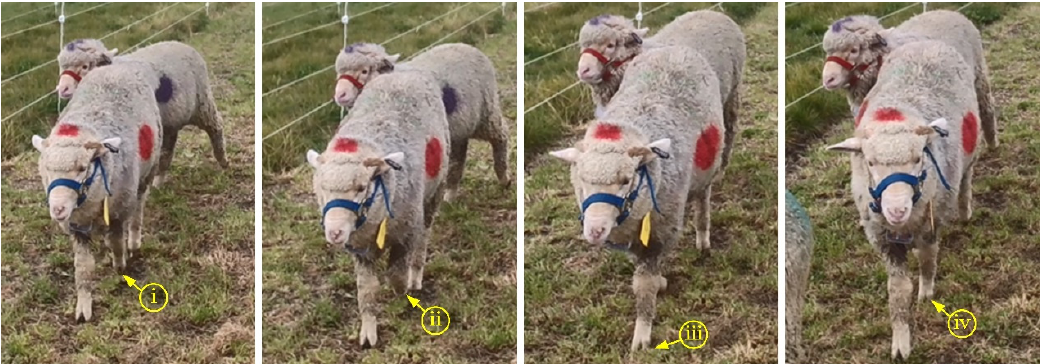
Figure 5. Decomposition movement of sheep’s typical walking behavior in one period. ( i ) The starting state of walking behavior; ( ii ) the sheep lifts the left leg; ( iii ) the body moves forward with the left leg; and ( iv ) the sheep lifts the right leg and moves forward with the right leg to the starting state.